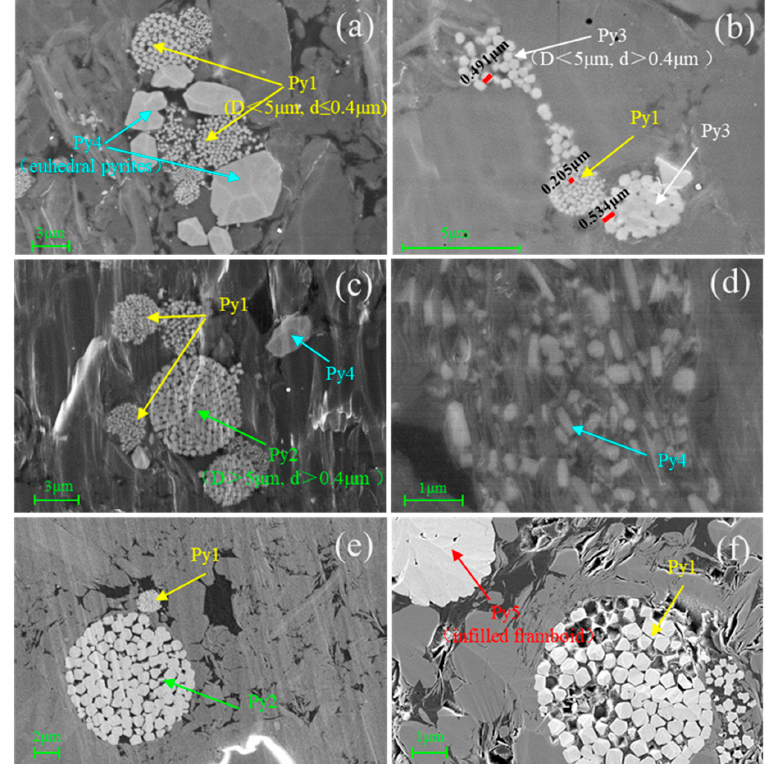
Figure 4. Pyrite micromorphology in the Longmaxi and Wufeng formations. ( a ) Syngenetic framboids (Py1) and small diagenetic euhedral pyrites (Py4) in the Wufeng black shale, 1520 m, well YY2; ( b ) pyrite framboids of similar size with di ff erent sized microcrystals between the syngenetic framboids (Py1) and late diagenetic framboids (Py3) in the Longmaxi black shale, 1510 m, well YY2; ( c ) in addition to Py1 and Py4, the early diagenetic framboid pyrites (Py2) are observed in the Longmaxi black-gray shale, 903 m, well LY1; ( d ) clay minerals and organic matter with euhedral pyrites in Lomgmaxi black shale, 925 m, well LY1; ( e ) early diagenetic framboid pyrites (Py2) in the Lomgmaxi shale, 921 m, well LY1; ( f ) infilled framboid (Py5) in the Longmaxi black shale, 1517 m, well